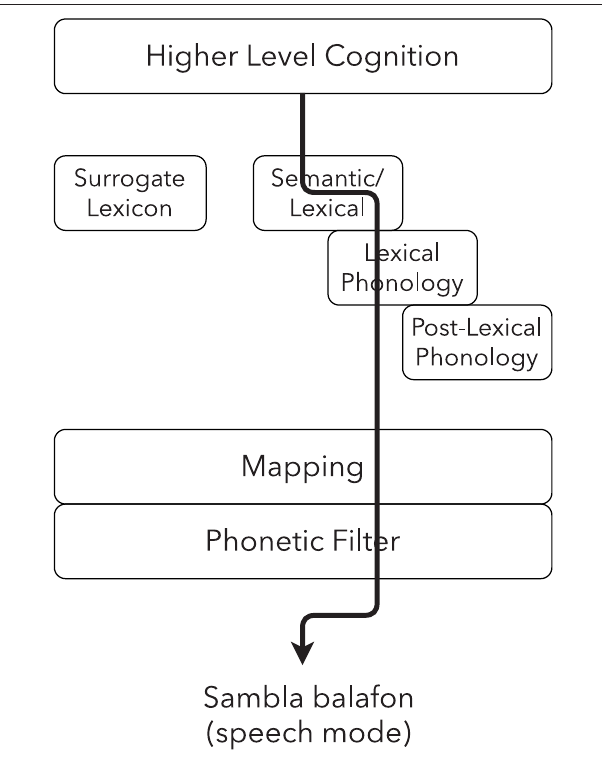
FIGURE 4 | Schema of Sambla balafon surrogate language